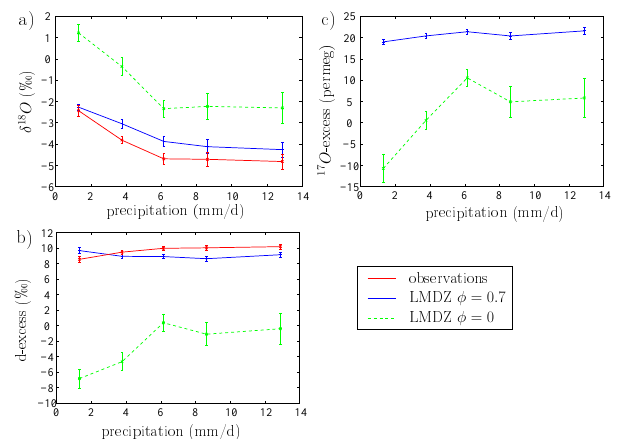
Fig. 6. Composites of precipitation δ 18 O, d-excess and 17 O-excess as a function of precipitation, in the control simulation of LMDZ, in a test in which φ = 0, and in observations. Precipitation range was divided into five bins for the composites. Error bars represent the standard deviation within each bin divided by the square root of the number of samples in the bin. LMDZ outputs were collocated with the GNIP observations they are compared with. All GNIP ob- servations in oceanic or coastal stations (altitude lower than 20m) in the tropics (equatorward of 30 ◦ ) are used. No 17 O-excess data are shown due to the lack of